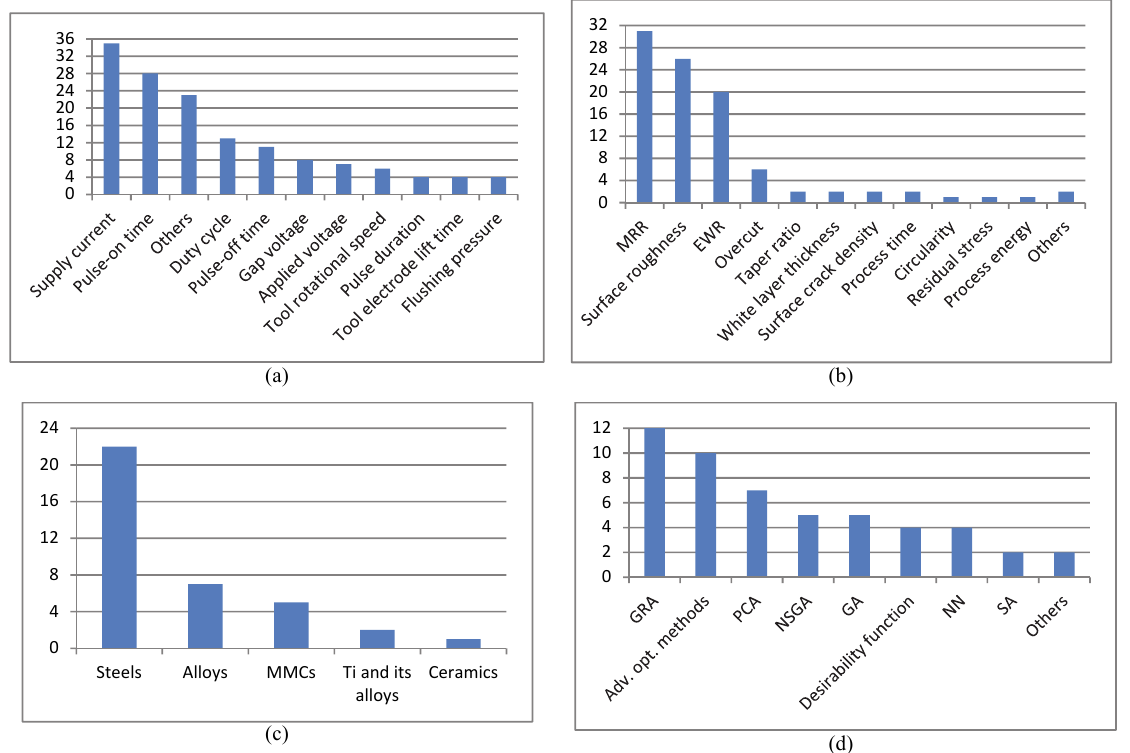
Fig. 2 Analysis on the parametric optimization of EDM